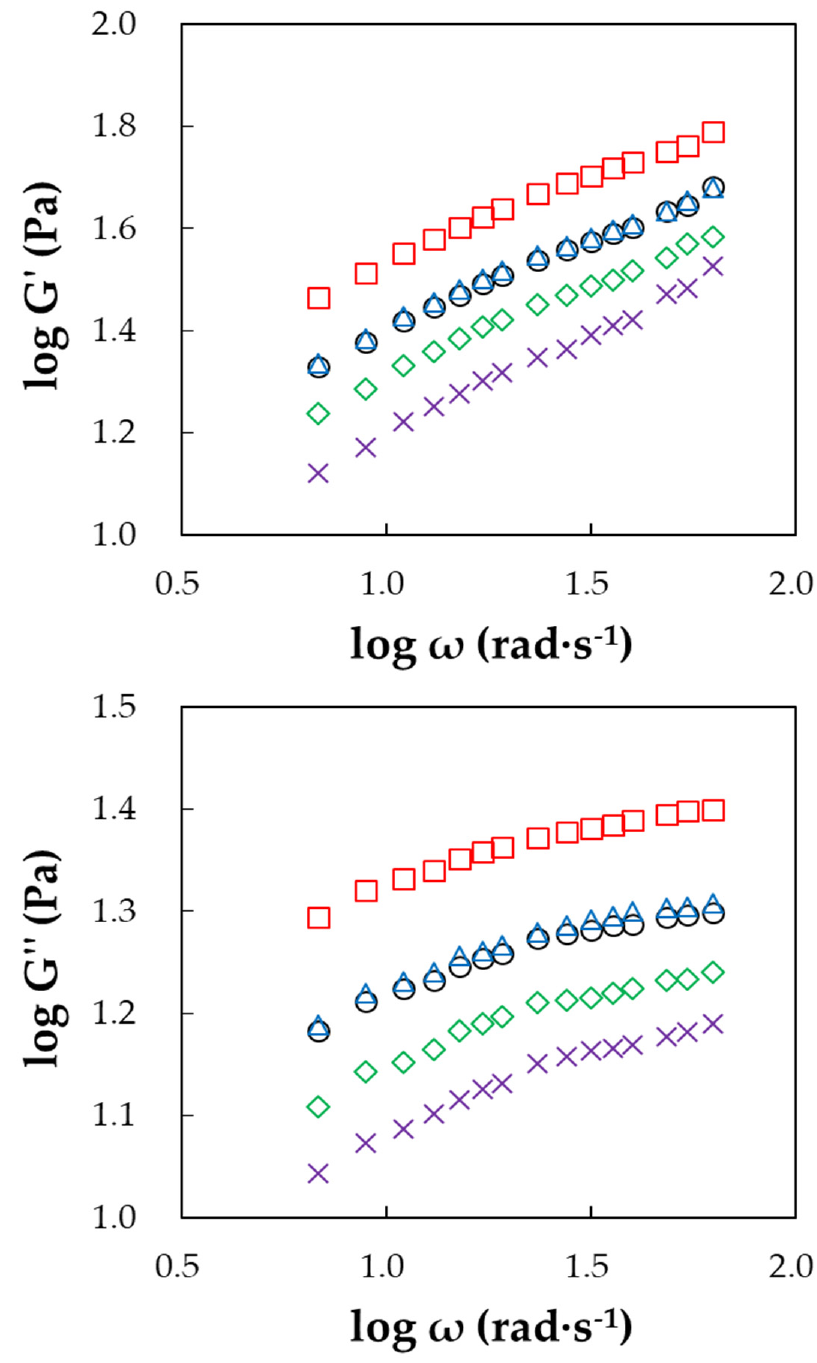
Figure 5. Plots of log G’ and log G’’ versus log ω for non-agglomerated and agglomerated guar gum (GG) with various concentrations of sucrose binder: ( ○ ) non-agglomerated GG, ( □ ) GG–0%, ( △ ) GG–10%, ( ◇ ) GG–20%, and (×) GG–30%.